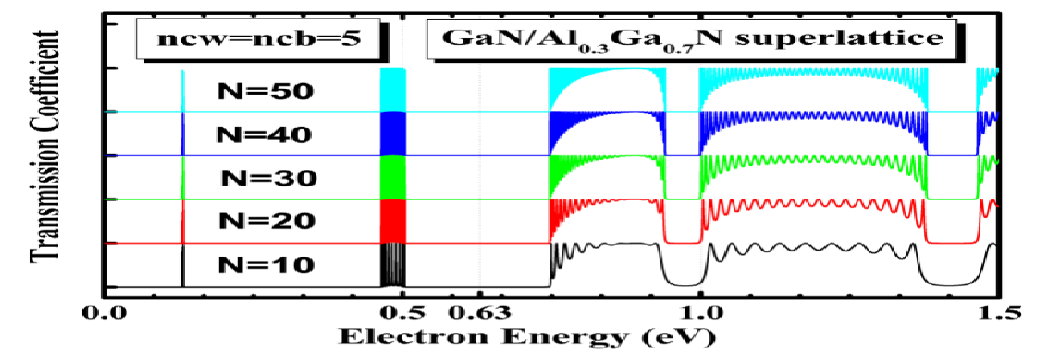
Fig.3:Transmission coefficient T(E) versus incident energy (E) for GaN/Al system for big number of barrier N, and constant ncw = ncb = 5.